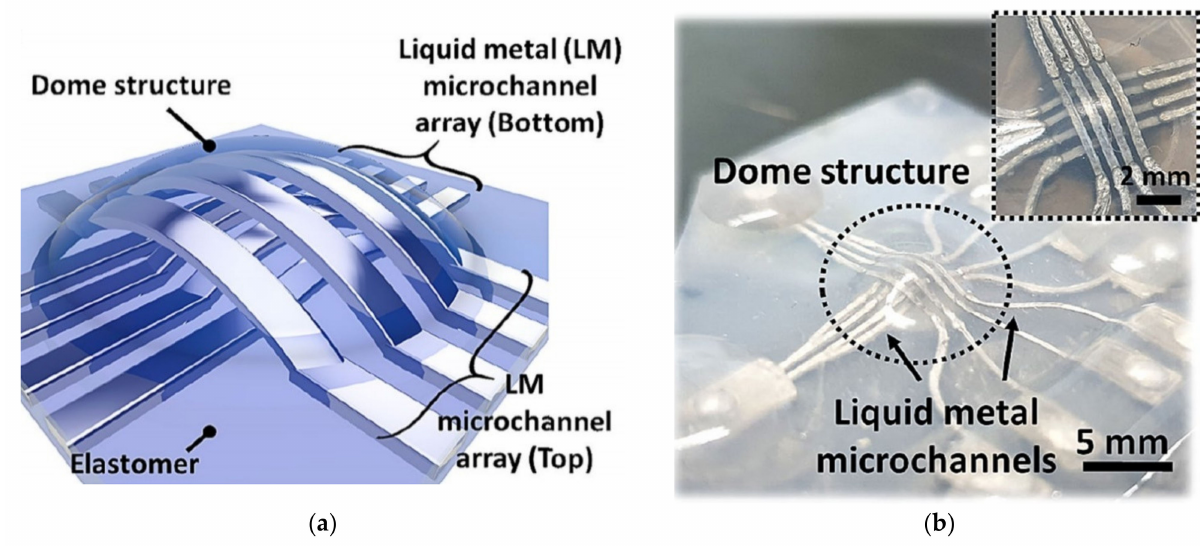
Figure 17. LM-based multiaxial force sensor with three-dimensional dome structure: ( a ) Schematic of the proposed sensor; ( b ) photograph of the proposed sensor. Reprinted with permission from Ref. [59]. Copyright 2021 Springer